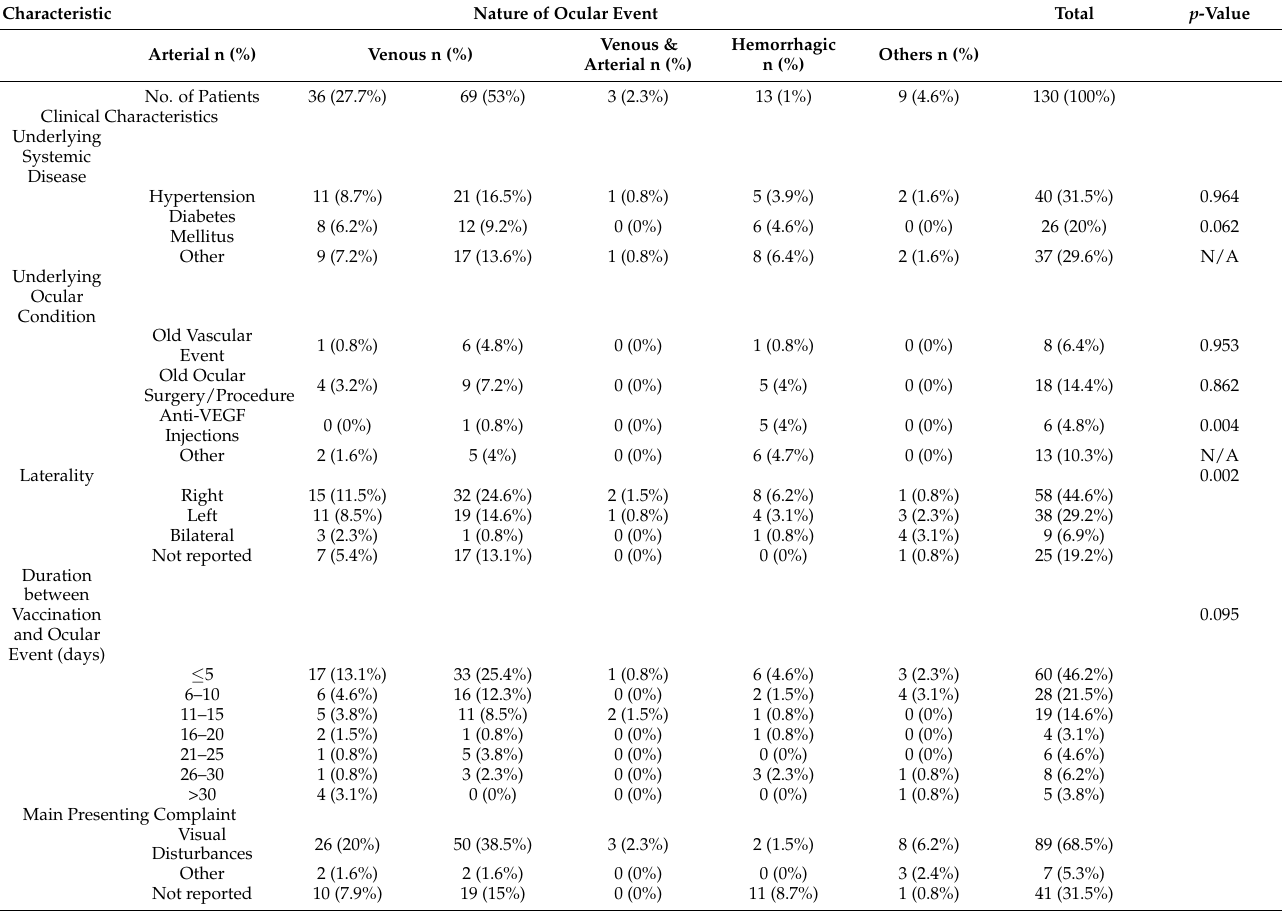
Table 3. Clinical characteristics of included cases.